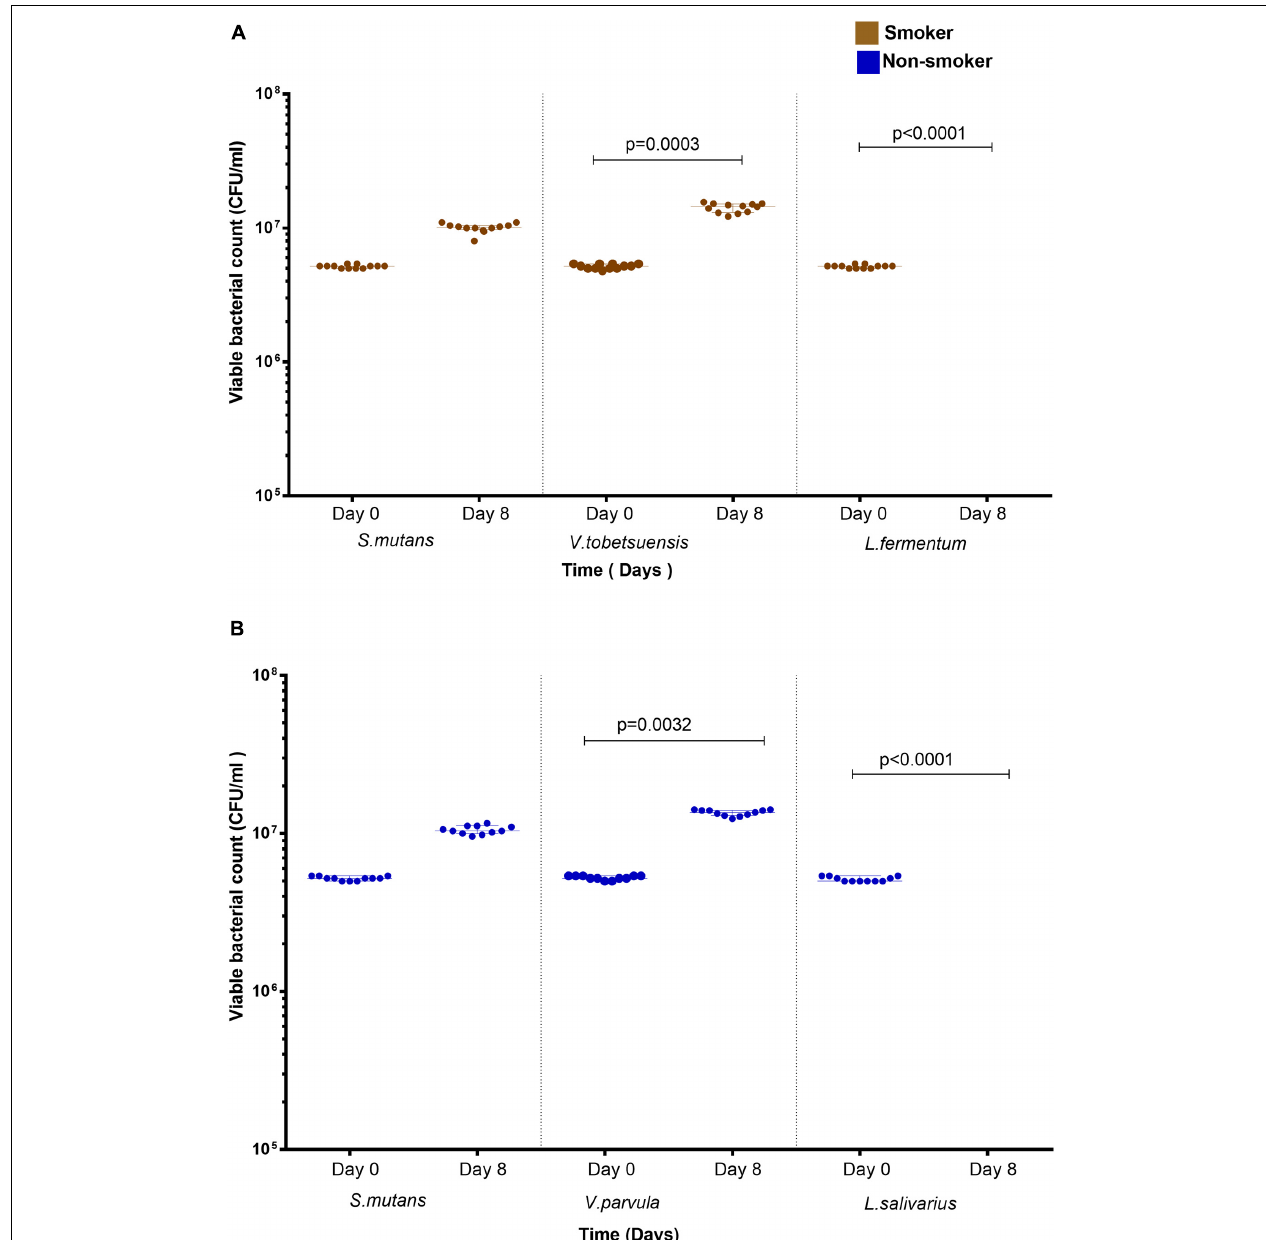
FIGURE 7 | Viable bacterial count of S. mutans , Lactobacillus spp., and Veillonella spp. triple assay in presence of anthracene as a sole carbon source at day 0 and day 8. (A) smokers and (B) non-smokers. For Lactobacillus spp., no colonies was detected at day 8. Statistical differences calculated using Kruskal-Wallis followed by multiple comparisons using Dunn’s corrections. Data presented as median ± interquartile range, where p < 0.05 was considered to be statistically